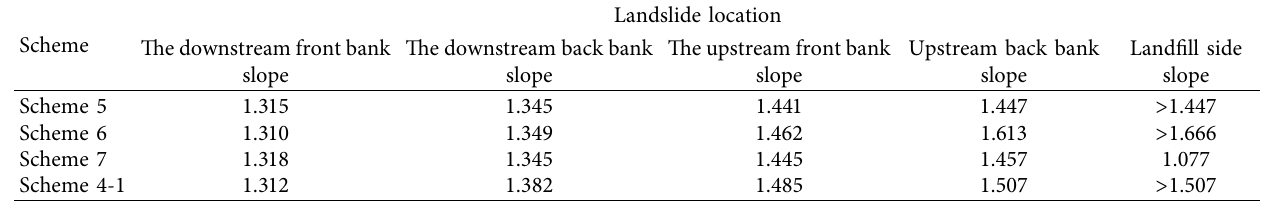
Table 8: Landfill slope safety factor of critical failure in four schemes.